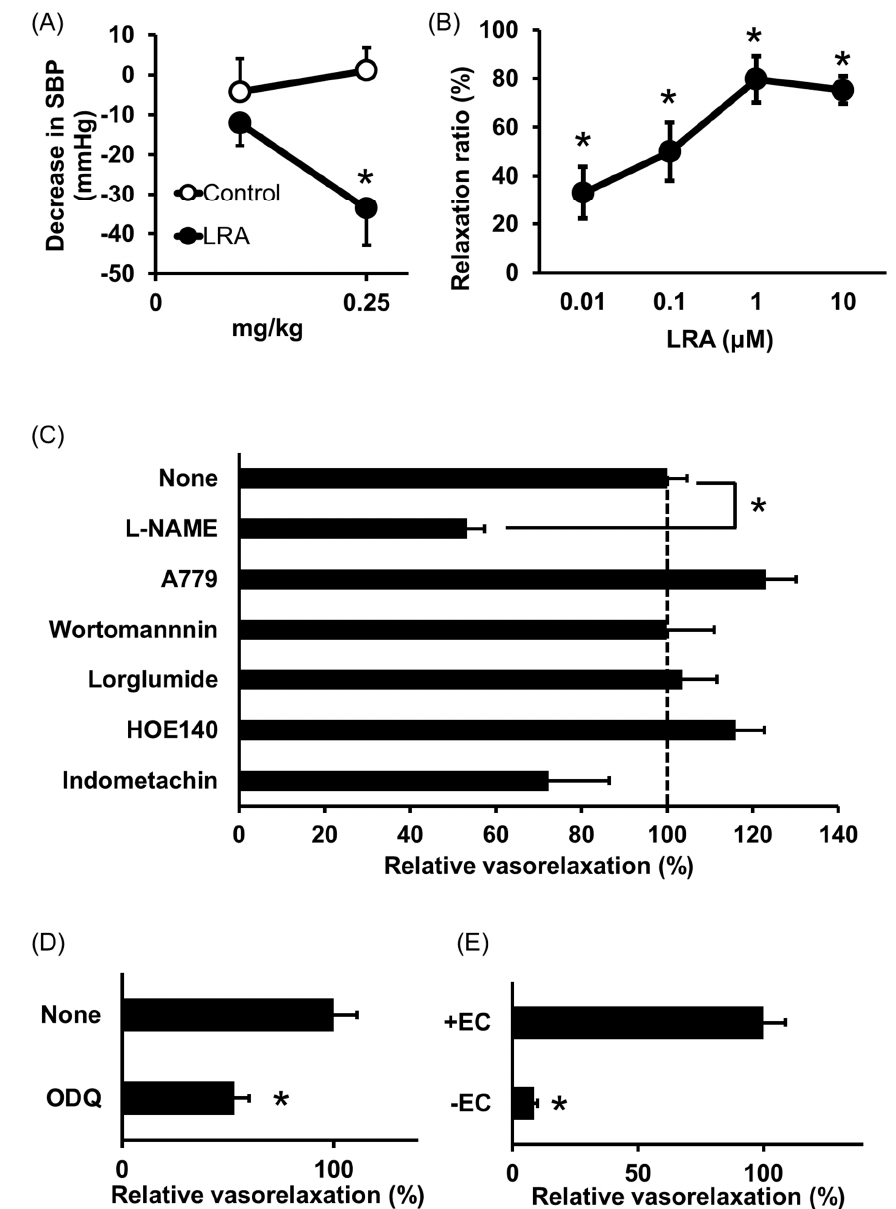
Figure 1. Anti-hypertensive e ff ect of Leu-Arg-Ala (LRA). ( A ) Minimum e ff ective dose was determined by in vivo study. Peptide samples were administered as a solution in saline. Each point represents the mean reduction in the systolic blood pressure (SBP) of SHRs and the vertical bars indicate the standard errors. * p < 0.05 indicates a significant di ff erence compared with the control group, which was administered the same volume of saline ( N = 5–10). These figures were modified and quoted from those previously reported by the author [26]. ( B ) Dose-dependency of the vasorelaxing activity of LRA. The peptide sample was applied for each concentration alone. The relaxation ratio was calculated using vasorelaxation with 100 µ M papaverine as 100%. * p < 0.05, vs. water control group. ( C , D ) E ff ects of vasorelaxing pathway blockers that function in the endothelial layer ( C ) or vascular smooth muscle layer ( D ) on LRA-induced vasorelaxation. LRA = 10 µ M, N = 4–8, * p < 0.05, vs. LRA alone. ( E ) Endothelial layer-removed samples (EC-) were also assessed. LRA = 10 µ M, N = 3–9, * p < 0.05, vs. LRA alone. These figures were modified and quoted from those previously reported by the author [27].